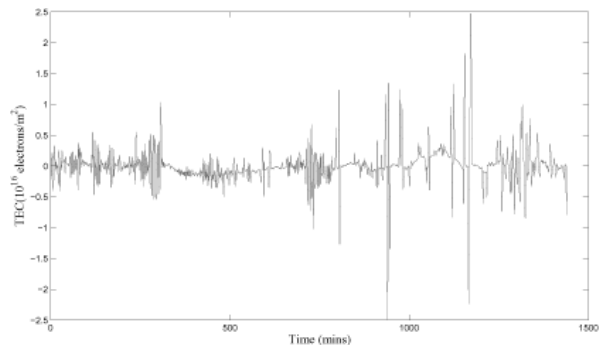
Fig. 2. A typical daily time series plot for the detrended TEC data measured from Lagos showing the typical pattern of variation.